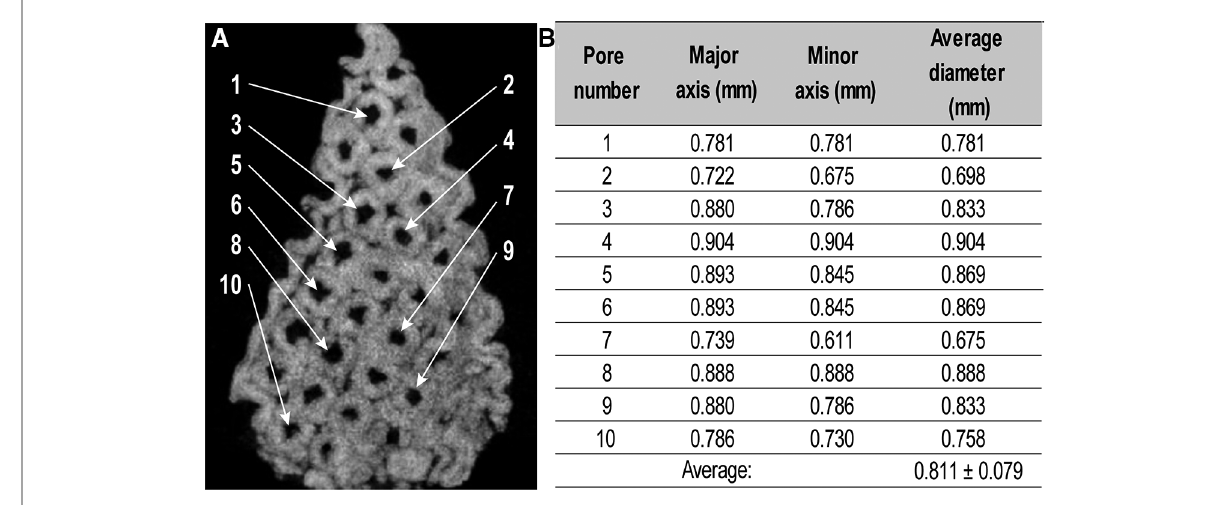
FIGURE 5 Measurement of pore sizes in a 3D printed TCP/HA sample by micro-CT. ( A ) The coronal cross-section from micro-CT image indicating the pores selected for measurement. ( B ). Corresponding pore dimensions, as determined by ImageJ